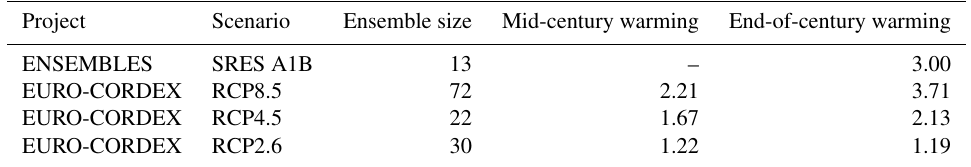
Table 2. Average global warming from driving GCMs in each scenario, weighted by the number of downscaling simulations of each. The warming is presented relative to the reference period 1981–2010 for mid-century (2041–2070) and end-of-century (2071–2100)